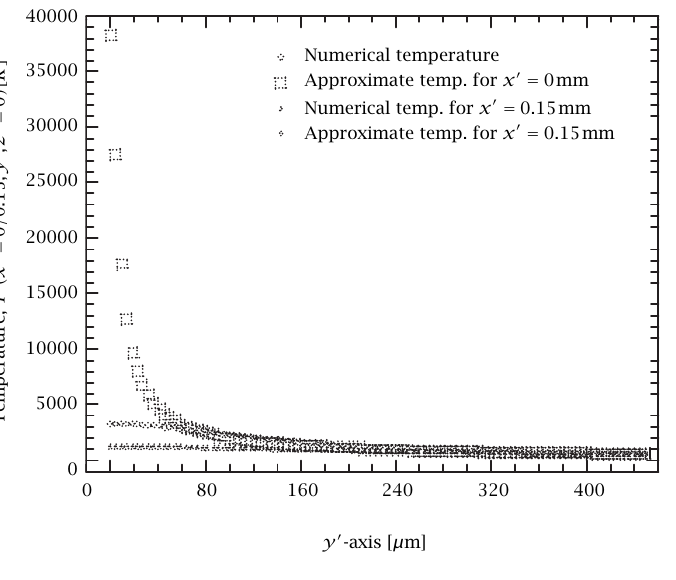
Figure 2.4 . Comparison between the numerical and approximate tempera- tures in the y (cid:1) direction for the different values of x (cid:1)